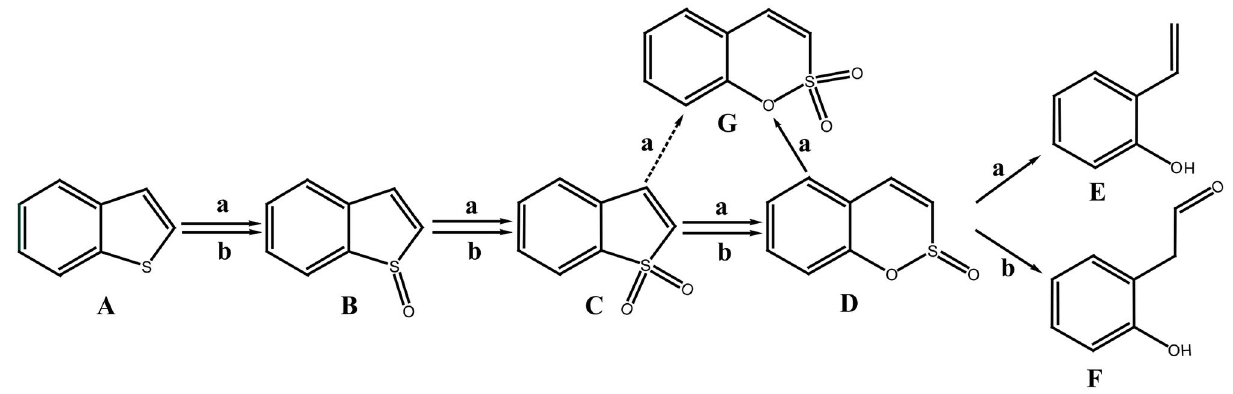
Figure 1. The proposed BT biodesulfurization pathway for Sinorhizobium sp. KT55 (a) and Gordonia sp. 213E (b). (A) benzothiophene; (B) benzothiophene S-oxide; (C) benzothiophene S,S-dioxide; (D) benzo[c][l,2]oxathiin S-oxide; (E) o- hydroxystyrene; (F) 2-(2’-hydroxypheny1)ethan-1-al; (G) benzo[c][1,2]oxathiin S,S-dioxide. doi: